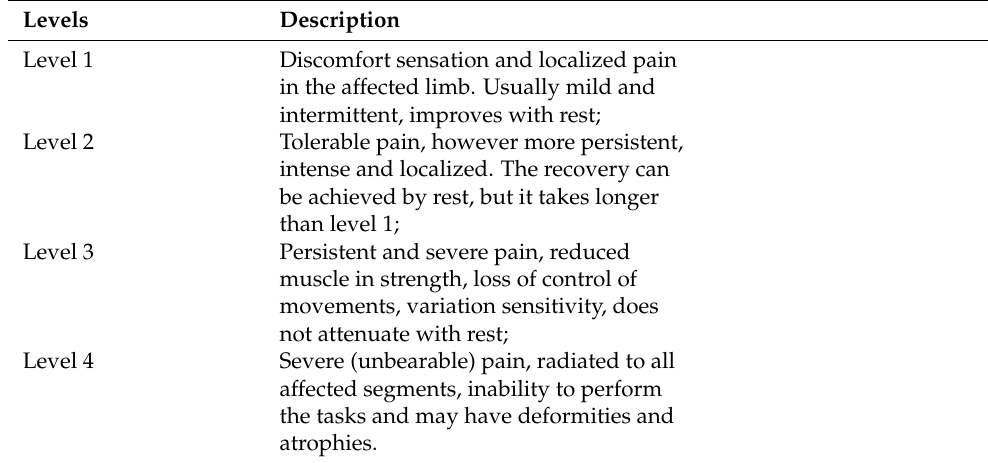
Table 1. WMSD—Main symptoms.